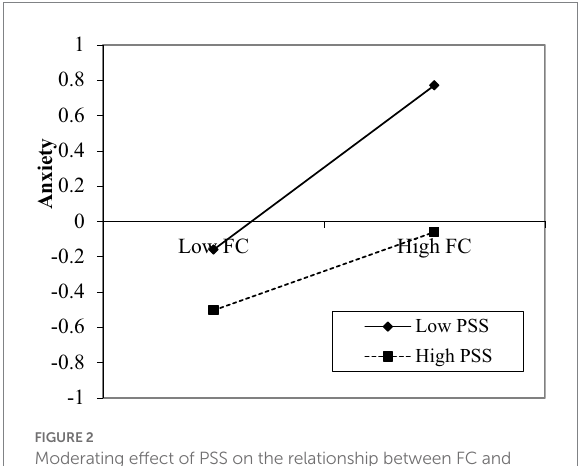
FIGURE 3 Moderating effect of SP on the relationship between anxiety and depression. SP, stress